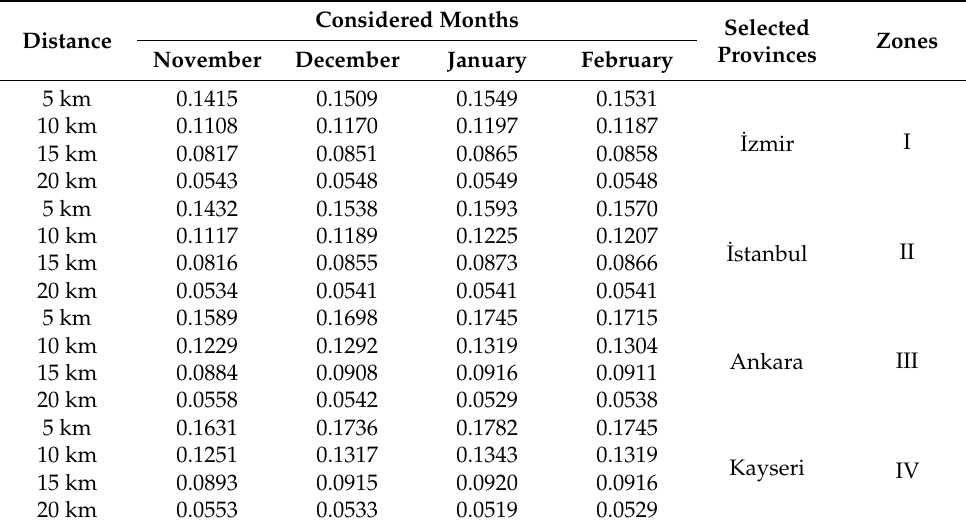
Table 7. Obtained functional exergy efficiency results of the whole system based on case